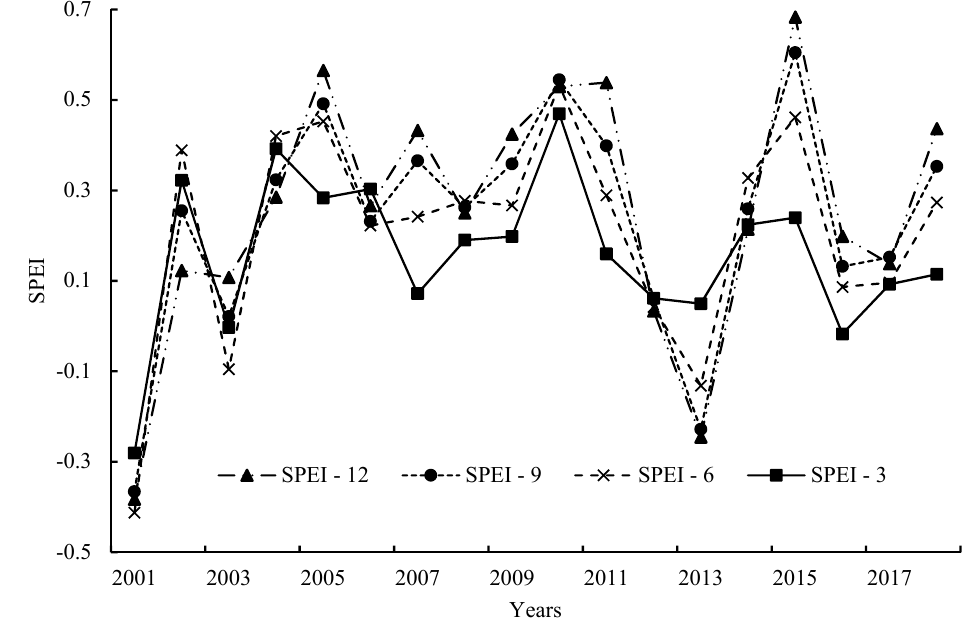
Figure 11. Interannual changes of SPEI at different time scales in YRB. Overall, the contribution of climate to NPP dynamics was positive in YRB. This find- ing is consistent with those of Yan et al. and of Zhu et al. [13,34], both of which have demonstrated that climate is favorable for forest growth. Forest restorations dominated by climate were mainly distributed in the upper YRB (Figure 7a,c). This result is similar to Wang et al. [5]. The reason is as mentioned above. the climate-dominated forest degra- dation was distributed in the middle YRB. Temperature and precipitation made the great- est negative effects on NPP changes in the middle YRB (Figure 6a,b). The temperature in the middle YRB increased (Figure 10b), while precipitation decreased (Figure 10b); which inhibited forest growth.